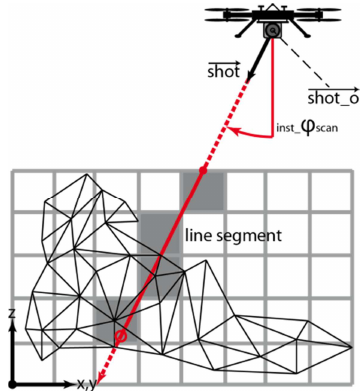
Figure 3. Principle of ray tracing, using an (instantaneous) input shot vector ( and an input mesh. Gray rectangles (cid:2)(cid:26)(cid:14)(cid:11) (cid:15)(cid:15)(cid:15)(cid:15)(cid:15)(cid:15)(cid:15)(cid:15)(cid:15)(cid:16) ,(cid:2)(cid:26)(cid:14)(cid:11)_(cid:14) (cid:15)(cid:15)(cid:15)(cid:15)(cid:15)(cid:15)(cid:15)(cid:15)(cid:15)(cid:15)(cid:15)(cid:15)(cid:15)(cid:16) (cid:23) tracing